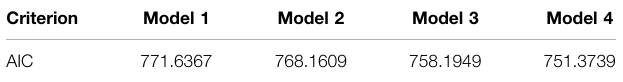
TABLE 6 | Akaike information